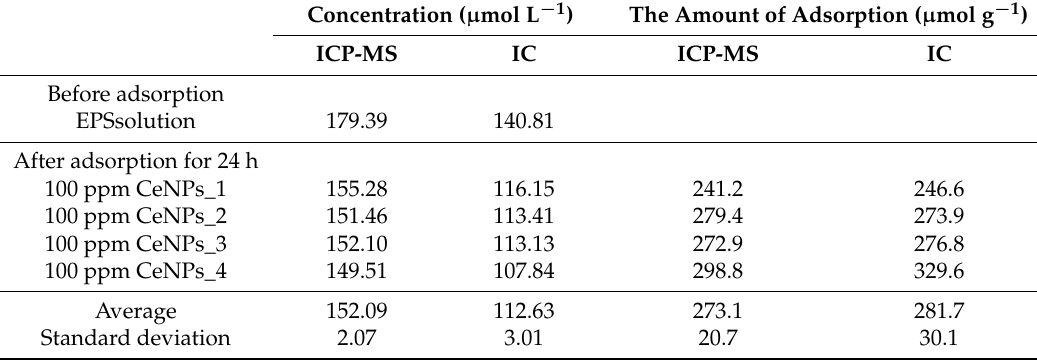
Figure 4. ( A ) Adsorption isotherm of DOC derived from EPS onto CeNP surfaces (=10 mg L − 1 ) as a function of pH after 1 h of adsorption; ( B ) Adsorption isotherm of inorganic phosphate onto CeNP surfaces (=10 mg L − 1 ) as a function of pH determined by ion chromatography (IC). The plots represent data of single measurement without standard deviation. The open circle represents the amount of adsorbed orthophosphate contained in EPS. The open triangle stands for the amount of the adsorbed inorganic phosphate. Table 3. Summary of phosphorus compounds analyzed by an inductively coupled plasma